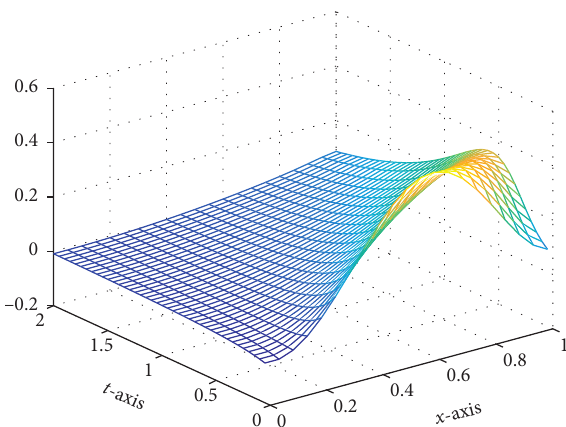
Figure 4: Graph of the numerical solution of p h � Δ t � 1/20.